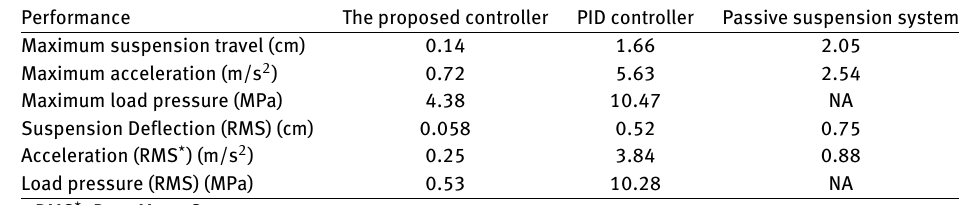
Table 7. Performance comparison while the system with nominal parameters is imposed by random road profile depicted in Figure 4.